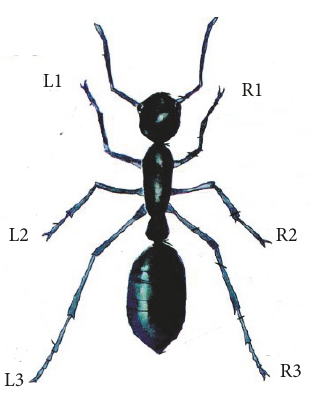
Figure 3: The serial number of ant’s leg.